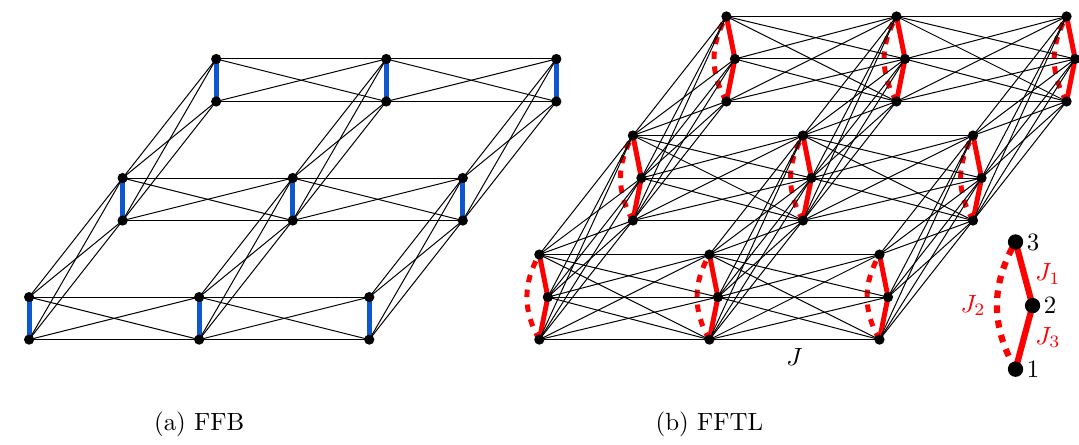
Figure 1: The fully frustrated bilayer (a) and trilayer models (b). In the trilayer, the layers are labelled 1, 2, 3 from bottom to top. The spins of a trimer unit cell (inset) are coupled by intra-trimer interactions J the nearest-neighbor unit cells by the same inter-trimer interaction, J (black). The dashed red line denoting the coupling ( J layers (3) of each trimer may differ from the other two couplings ( J